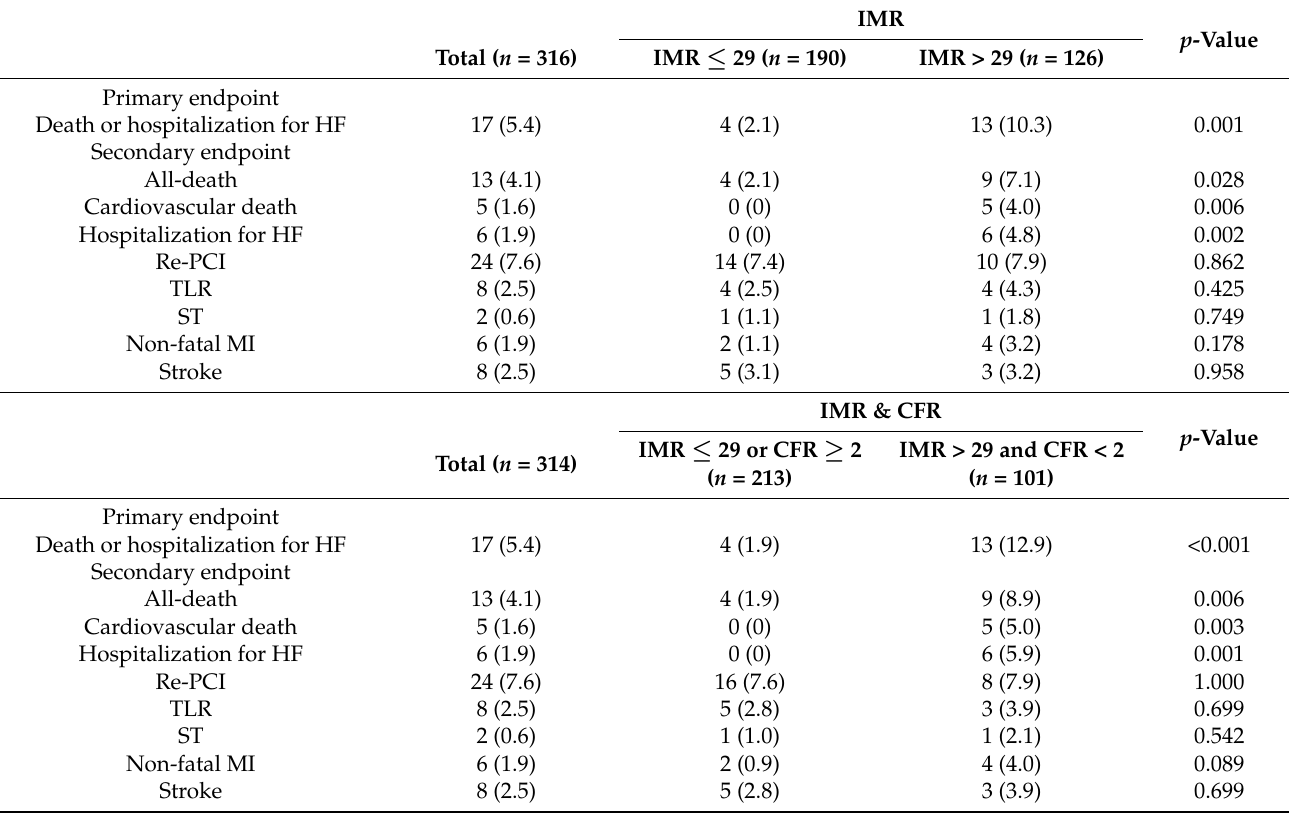
Figure 1. Absolute changes of echocardiographic measurements. LVEF: left ventricular ejection fraction; IMR: index of the microcirculatory resistance. Table 4. Long-term clinical